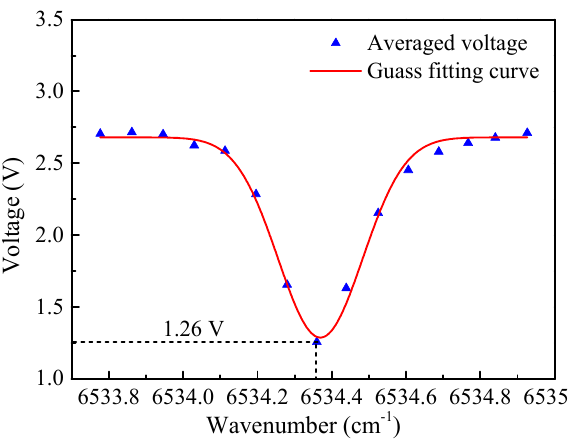
Figure 8. Absorption spectrum of 10 ppm C 2 H 2 .